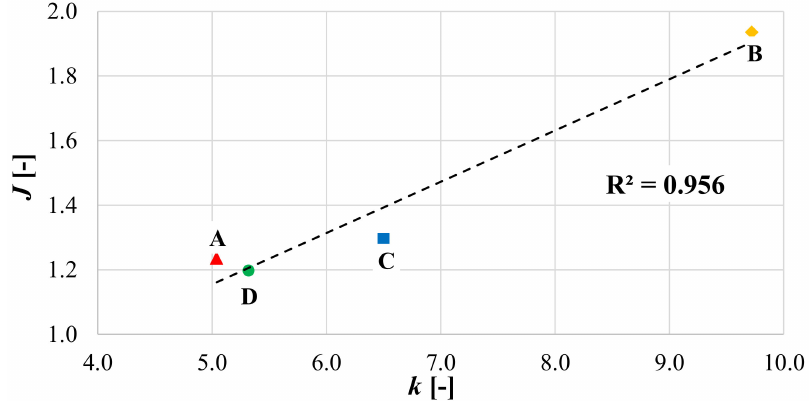
Figure 11. Correlation between the performance coefficient k and the J